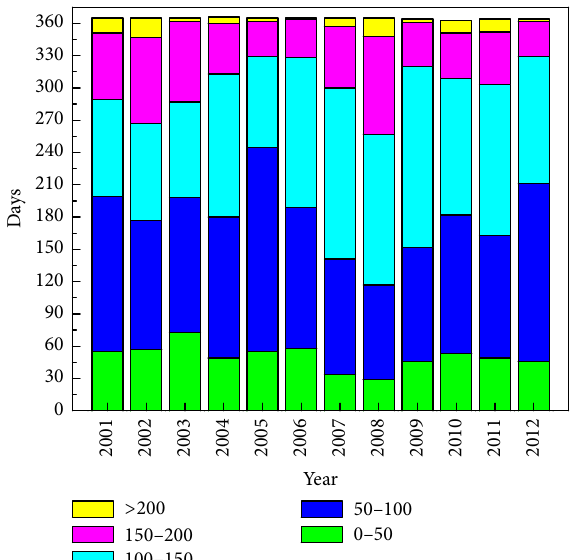
Figure 3: Frequency distribution of daily PM 10 concentration in Hefeiduringtheperiodfrom2001to2012.Note:PM 10 concentration unit: 𝜇 g m −3 .